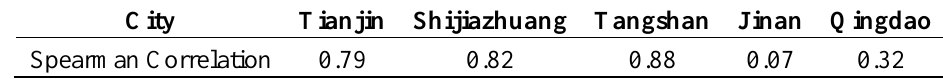
Table 2. Spearman correlation of Z-score of mean MODIS AOT values of the APEC period (1–11 November) between Beijing and Tianjin, Shijiazhuang, Tangshan, Jinan, and